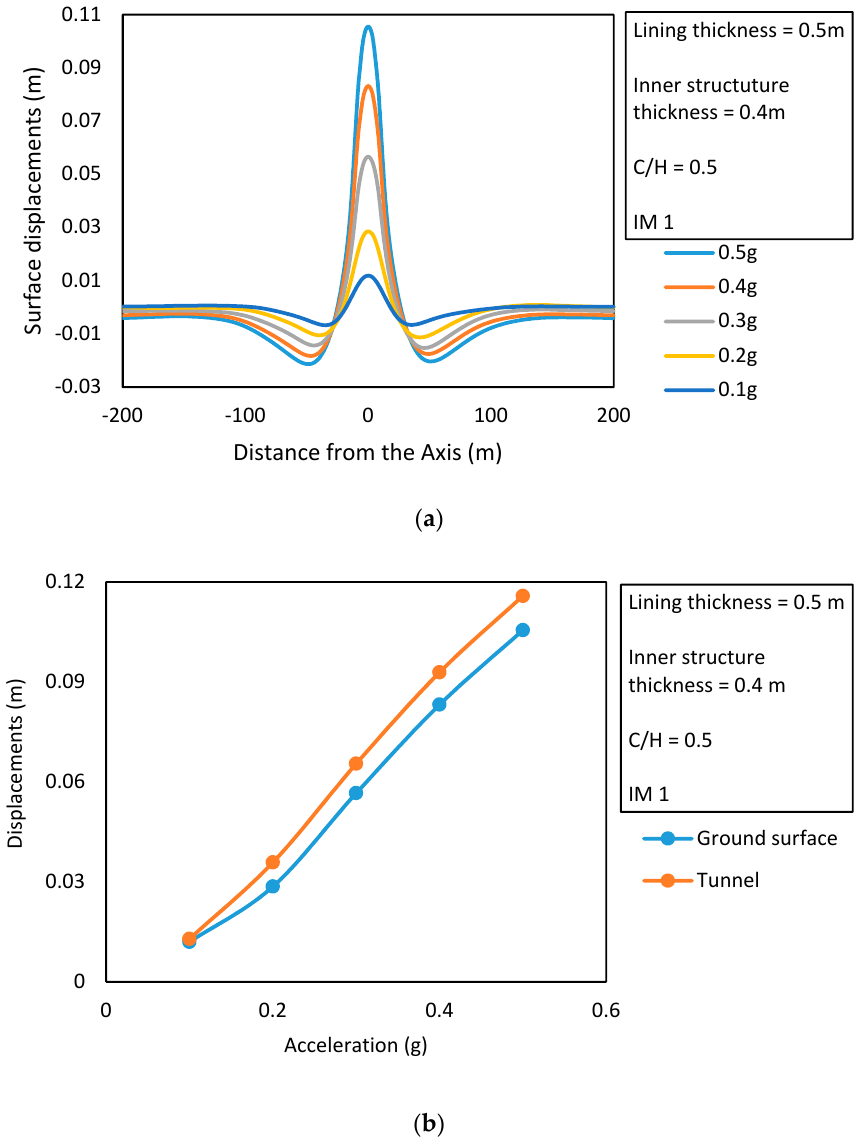
Figure 6. ( a , b ) Effect of variation in the amplitude of input motion on ( a ) surface settlements and ( b ) tunnel uplift in comparison to the surface heave.